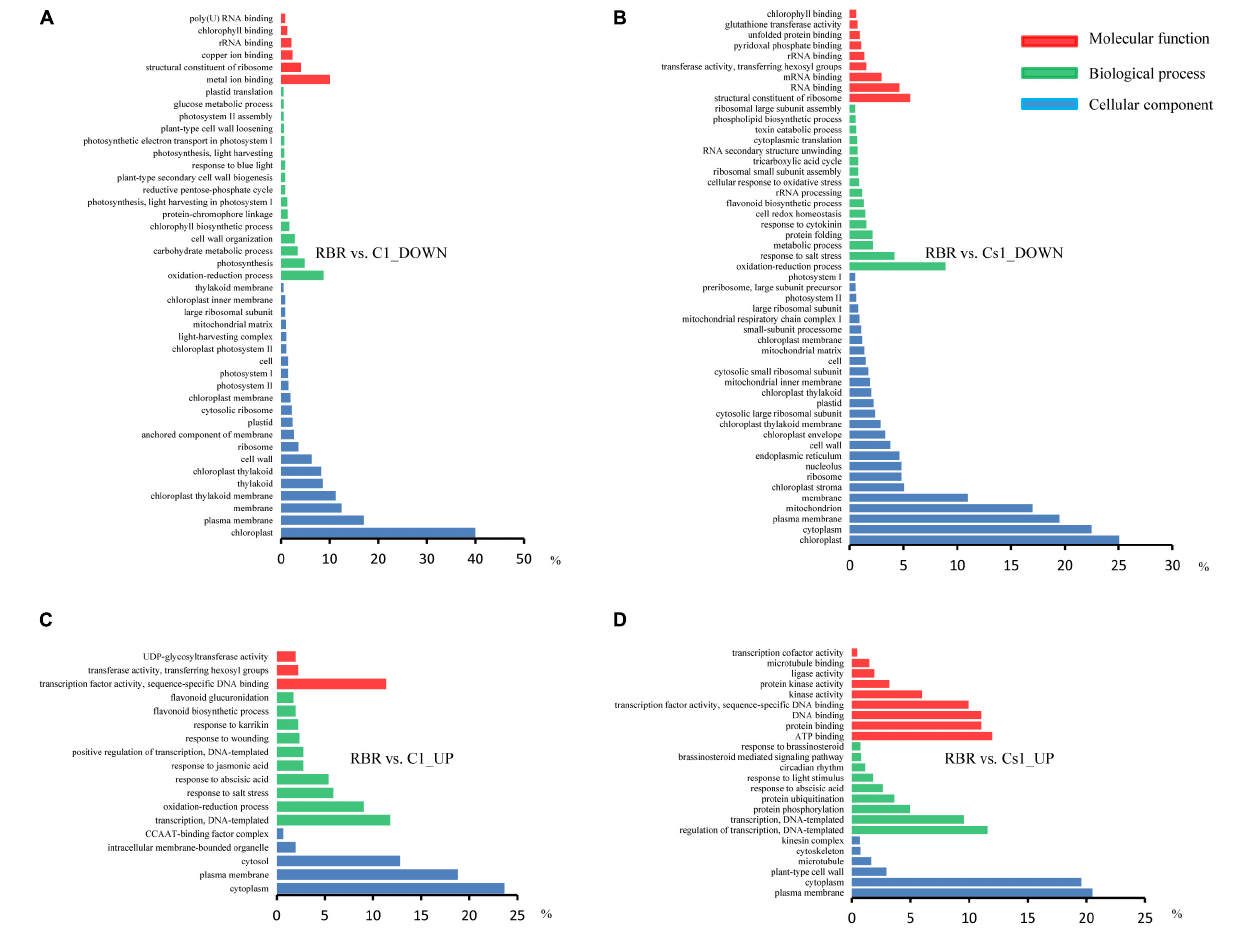
FIGURE 5 | GO analysis of trans-effected DEGs in two comparisons of RBR vs. C1 and RBR vs. Cs1 annotated by three categories: cellular component ( blue ), molecular functions ( red ) and biological process ( green ). (A,B) Go annotation for down-regulated genes in both comparisons. (C,D) The reduced GO terms were clustered in up-regulated genes in both